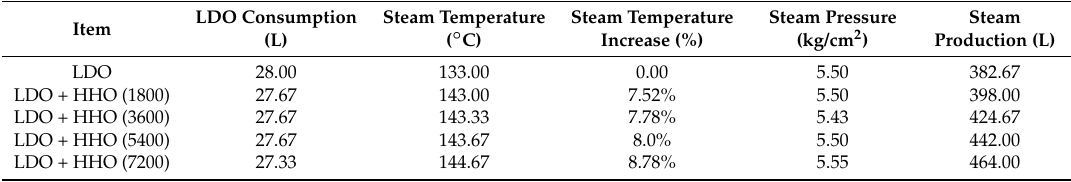
Table 9. Average increases (%) of LDO consumption and steam production when combining LDO with various amounts of HHO.